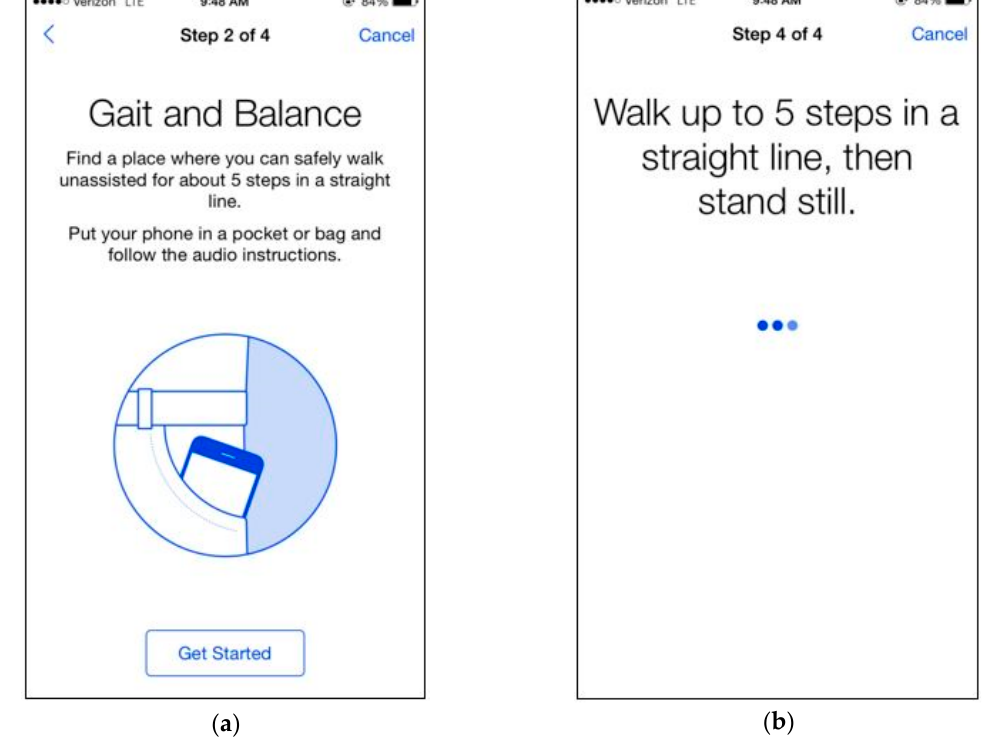
Figure 1. DrinkTRAC app screenshots of the tandem gait task. ( a ) Screenshot showing an example instruction screen from the Gait Task; ( b ) Screenshot showing another example instruction screen from the Gait Task.